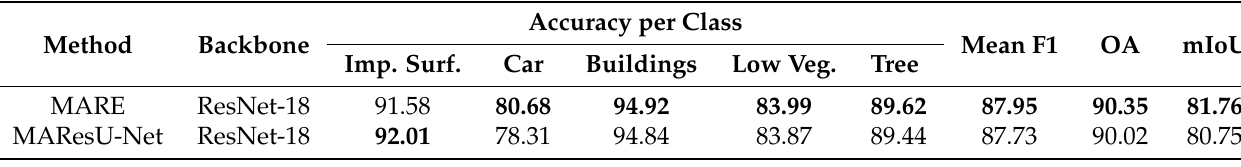
Table 3. Comparison among MAResU-Net trained with a ResNet-18 backbone and MARE. The SSL pretraining strategy of the ResNet-18 encoder is effective, allowing the architecture to achieve the best results (e.g., 81.76% mIoU) in literature with this type of encoder.